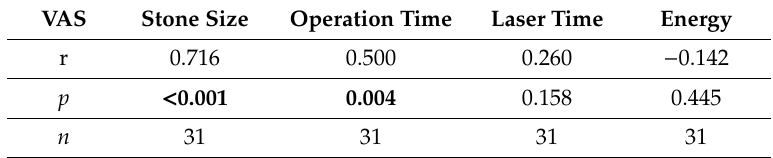
Table 5. Correlation between VAS scores and stone size, length of operation, laser time and energy levels.